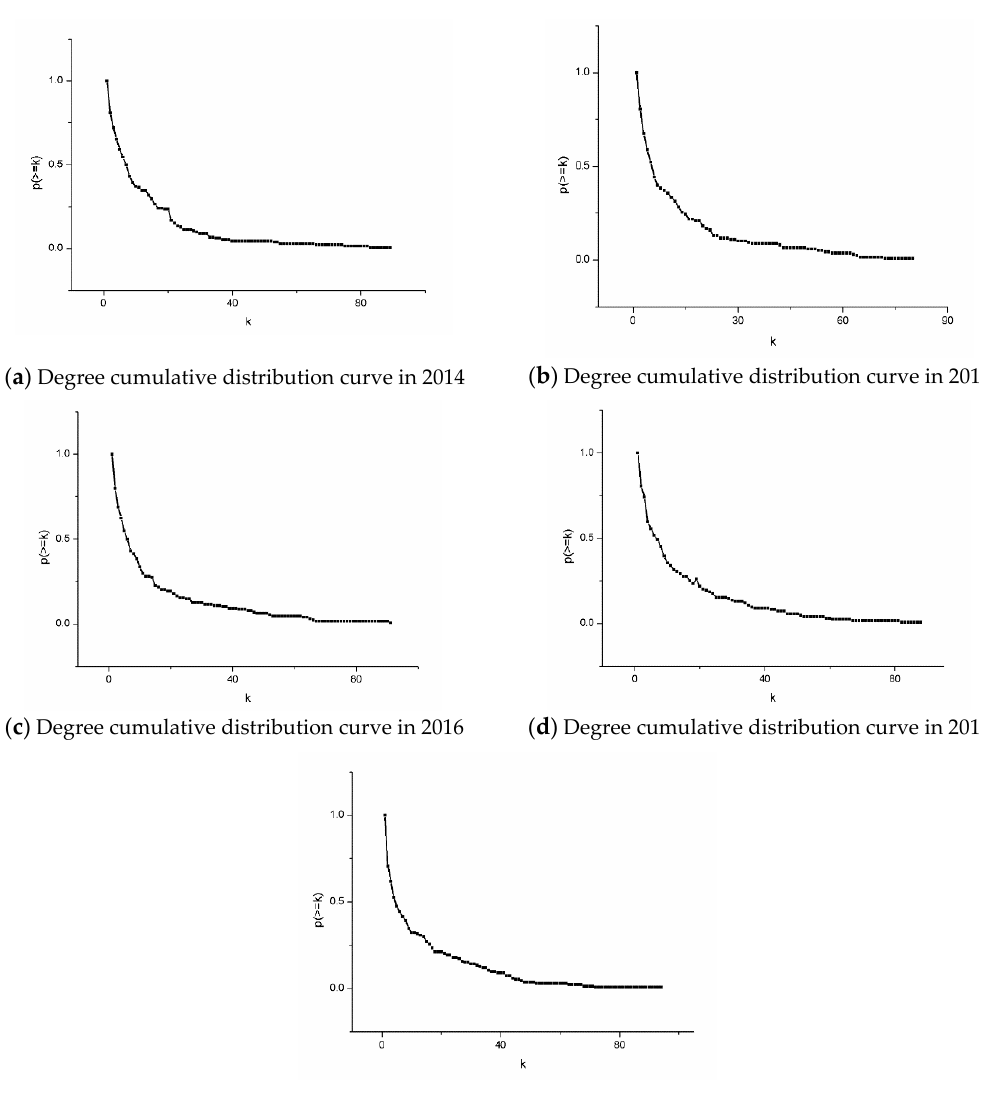
Figure 4. The statistical indicators of degree centrality curve during 2014–2018. Table 2. The core authors of each year. 2014